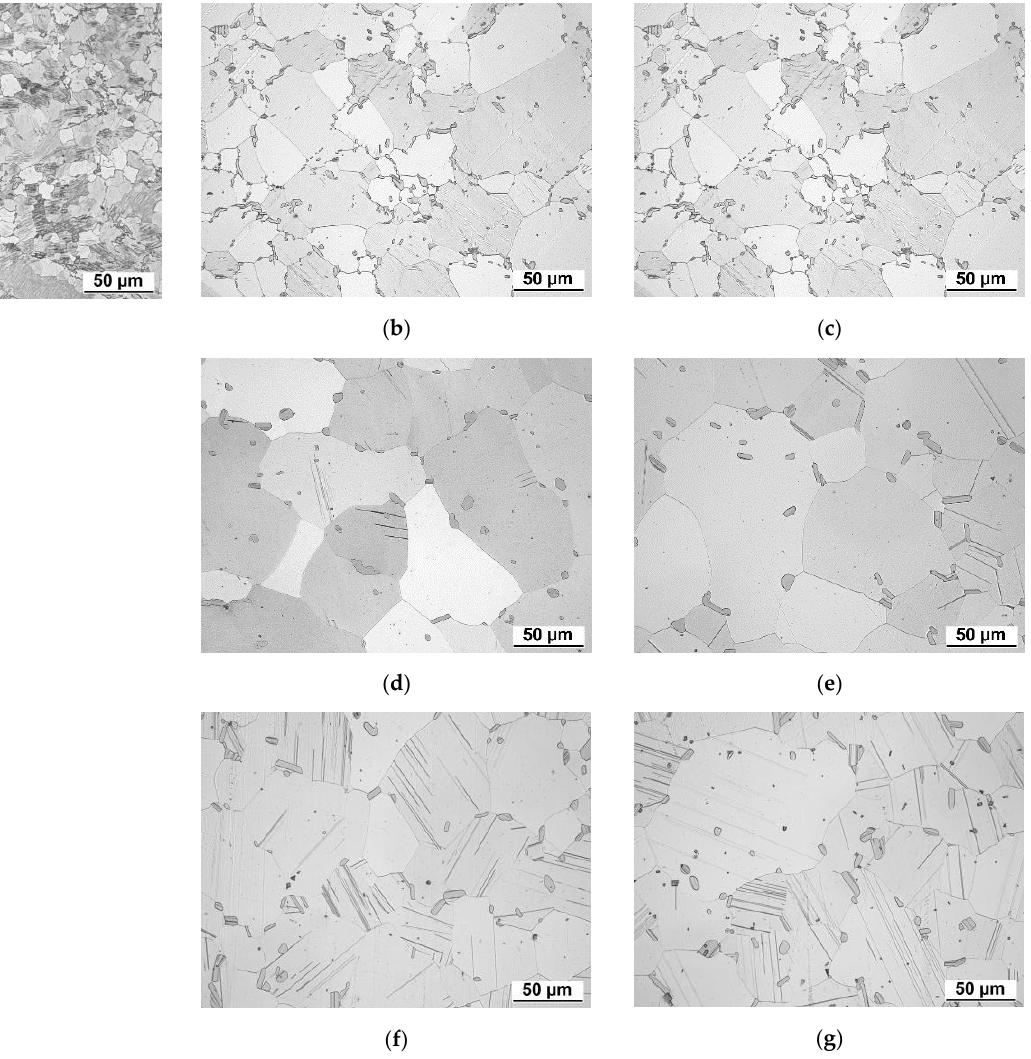
Figure 1. Light micrographs of Mg-Dy-Nd-Zn-Zr alloy in ( a ) as-extruded state, showing LPSO lamellae within the grains, precipitates and grain boundary LPSO phases after heat treatment at 500 °C for ( b ) 0.5 h, ( c ) 1 h, ( d ) 24 h, ( e ) 72 h, ( f ) 96 h and ( g ) 120 h, followed by quenching in 55 °C warm water, showing LPSO lamellae within Mg matrix grains and blocky LPSO within grains and at grain boundaries of different quantities.